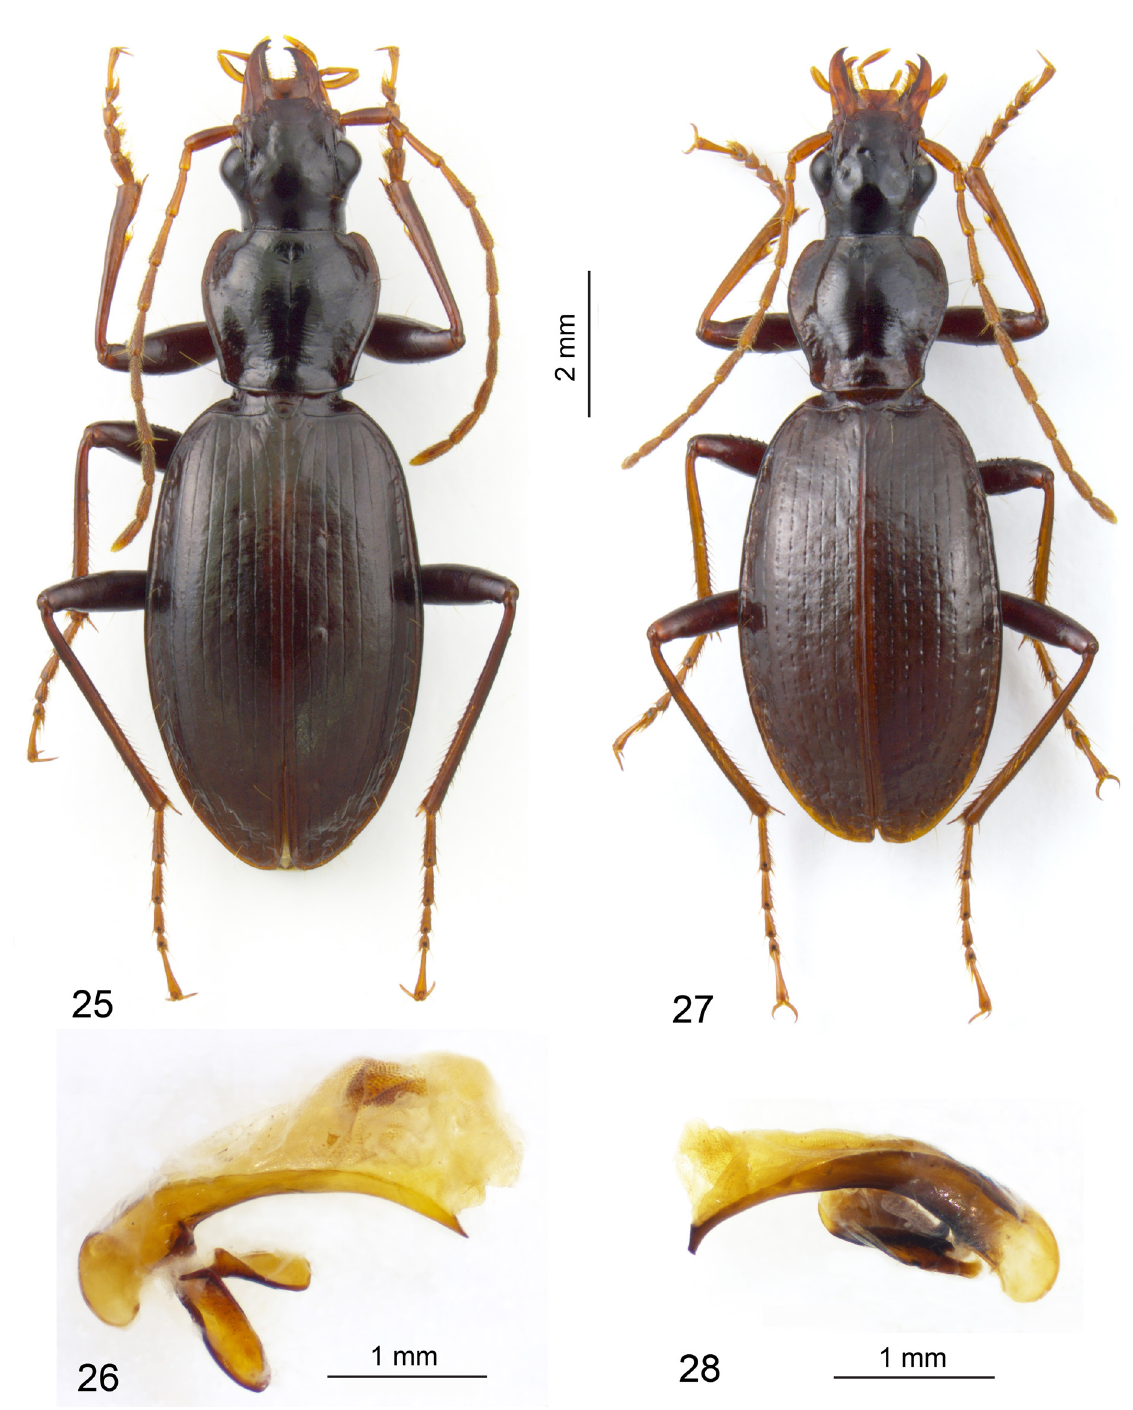
Figs 25–28. 25–26 . Dyscolus arborarius Moret sp. nov. 25 . Habitus of the male holotype (MNHN, COI voucher PM170-02). 26 . Aedeagus, median lobe in lateral view. 27–28 . D. famelicus Moret sp. nov. 27 . Habitus of a female paratype (CPM). 28 . Aedeagus, median lobe in lateral